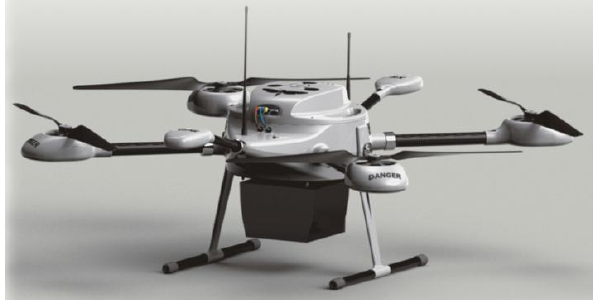
Figure 1. The Hawk Moth platform with the YellowScan scanner